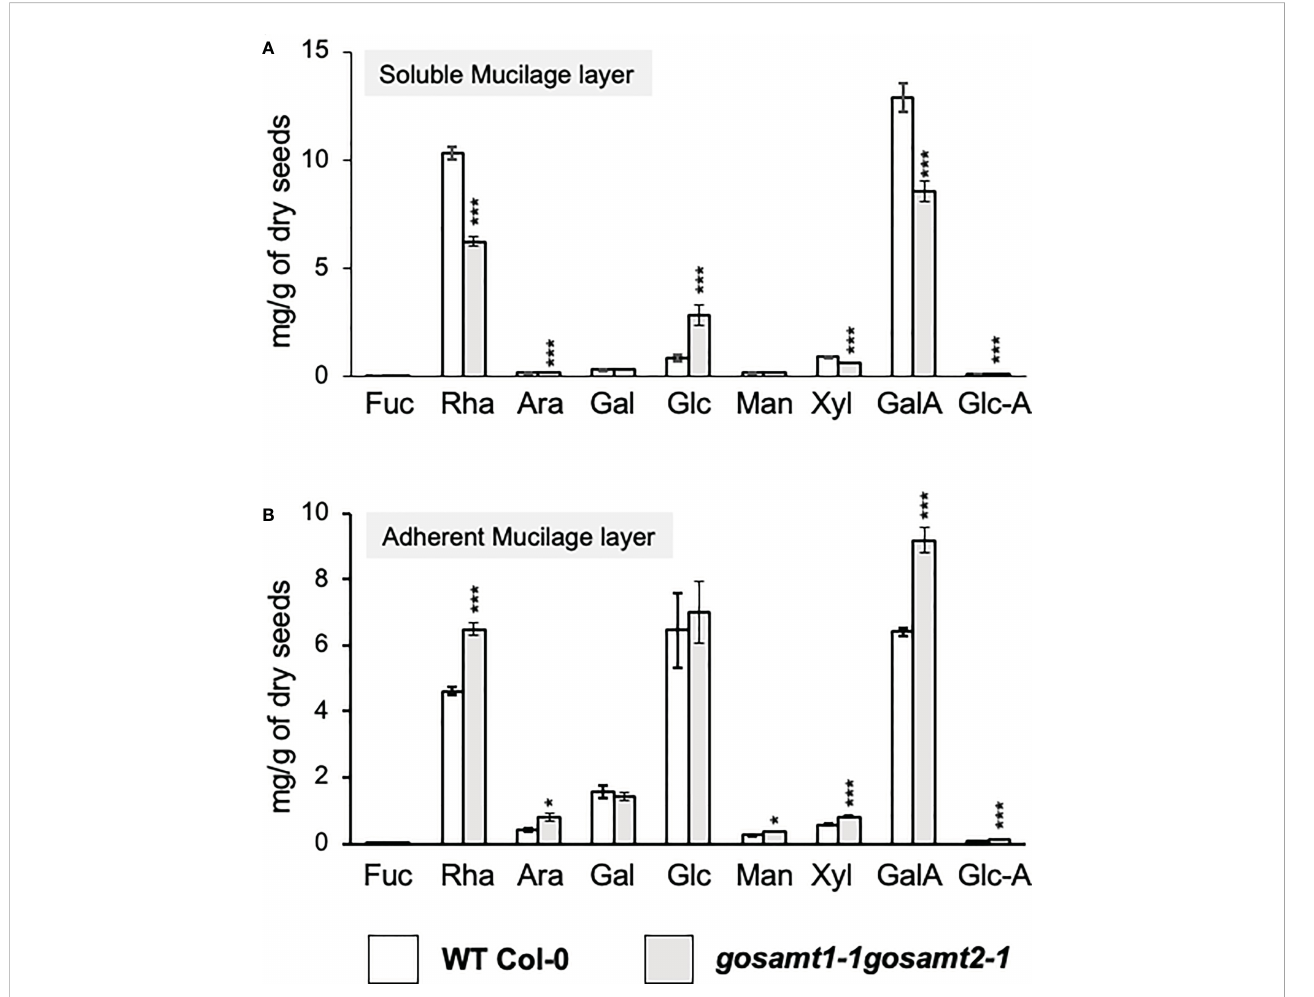
FIGURE 10 Monosaccharide content in mucilage layers of wild-type and gosamt1-1 gosamt2-1 mature dry seeds. Quanti fi cation of the monosaccharide composition in SM (A) and AM (B) fractions using HPAEC-PAD. Error bars represent SE from three biological replicates ( n = 12). Signi fi cant differences between genotypes are presented in asterisks. Statistical analyses were performed by using the Mann-Whitney test (* P < 0.05; *** P <